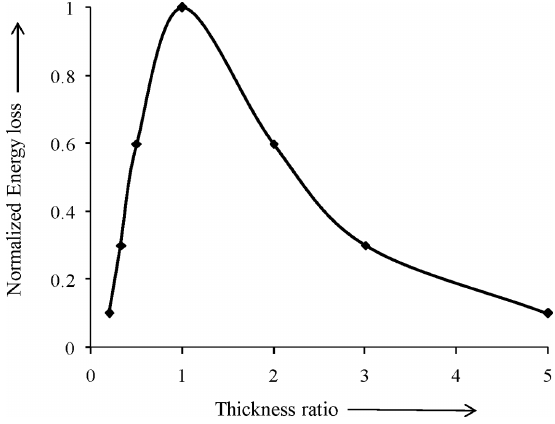
Fig. 5. Variation of normalized energy loss with thickness ratio for welded cantilever